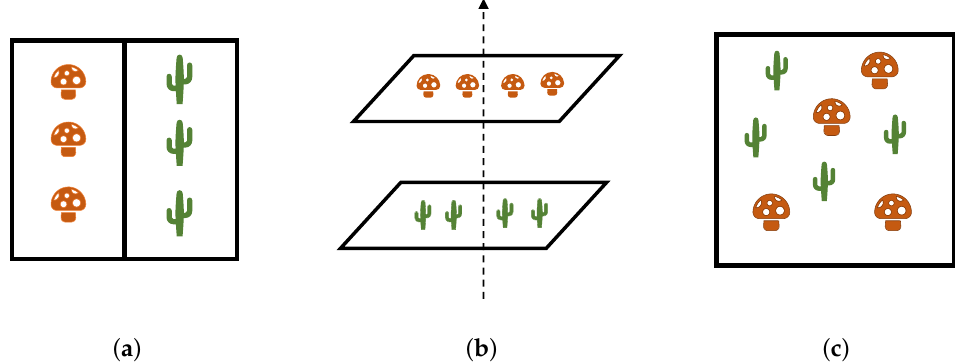
Figure 1. Three possible configurations of pigment mixing. ( a ): Optical blending occurs when two materials are physically separated but mixed at the camera level. ( b ): A layered structure assumes that light is transmitted and reflected according to the properties of the different layers. ( c ): In the intimate mixing the components are not physically discernible.